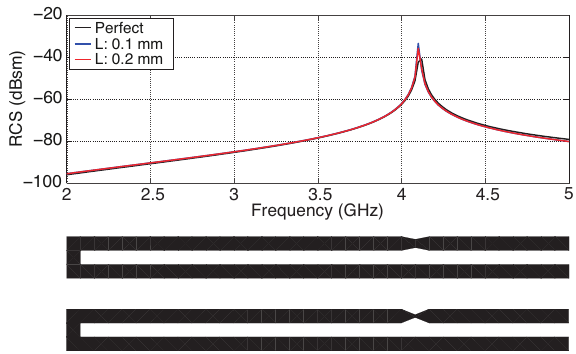
Figure 7: Electromagnetic responses of RFID tags that are obtained by deleting blocks of four or five bits from the overall structure in Fig. 1.